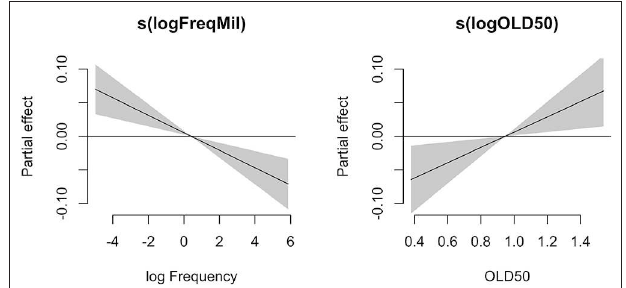
FIGURE 6 | Partial effect estimates from the GAMM model. Left: Effect of frequency on the first keystroke latencies of Suffix-words. Right: Effect of OLD50 (orthographic similarity measure) on the first keystroke latencies of Suffix-words.